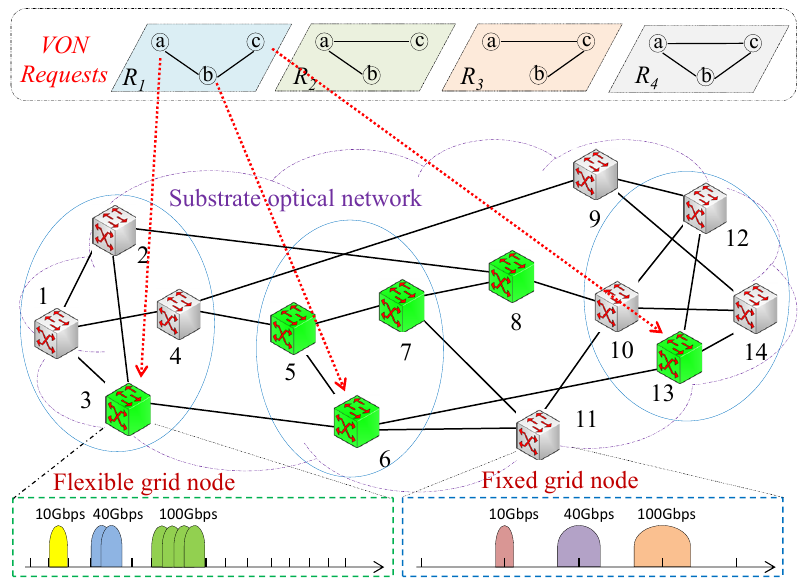
Figure 1. VON provisioning over fixed/flexible grid optical networks.